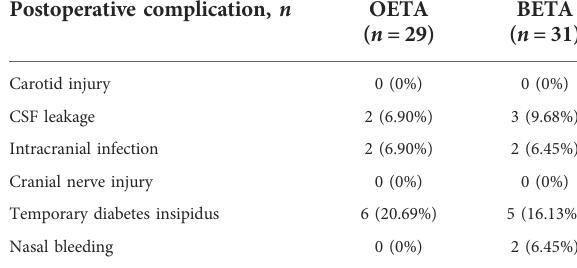
TABLE 4 Postoperative